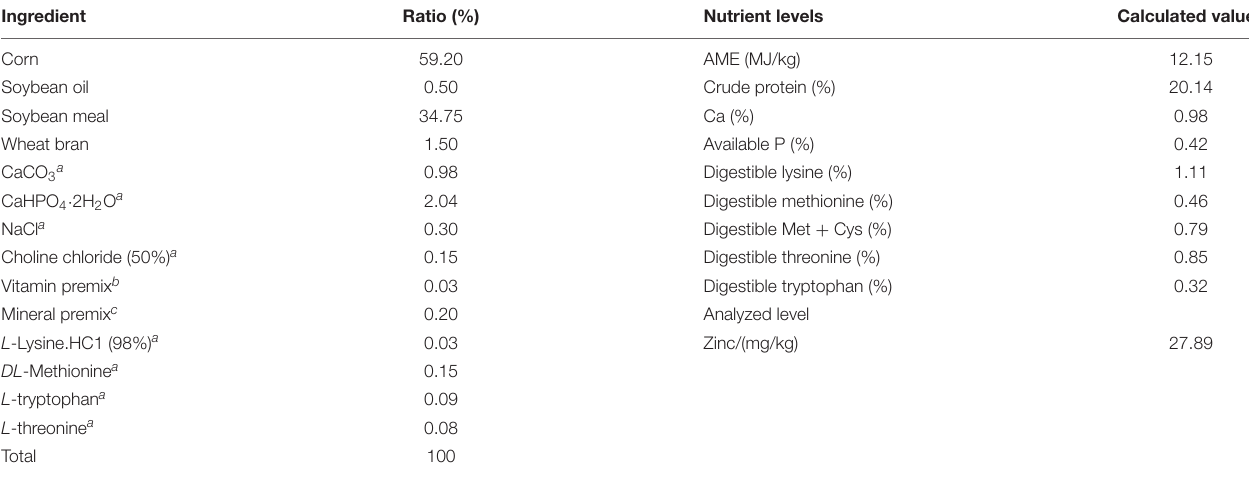
TABLE 1 | Composition and nutrient levels of the basic diets for meat ducks (air-dry basis).